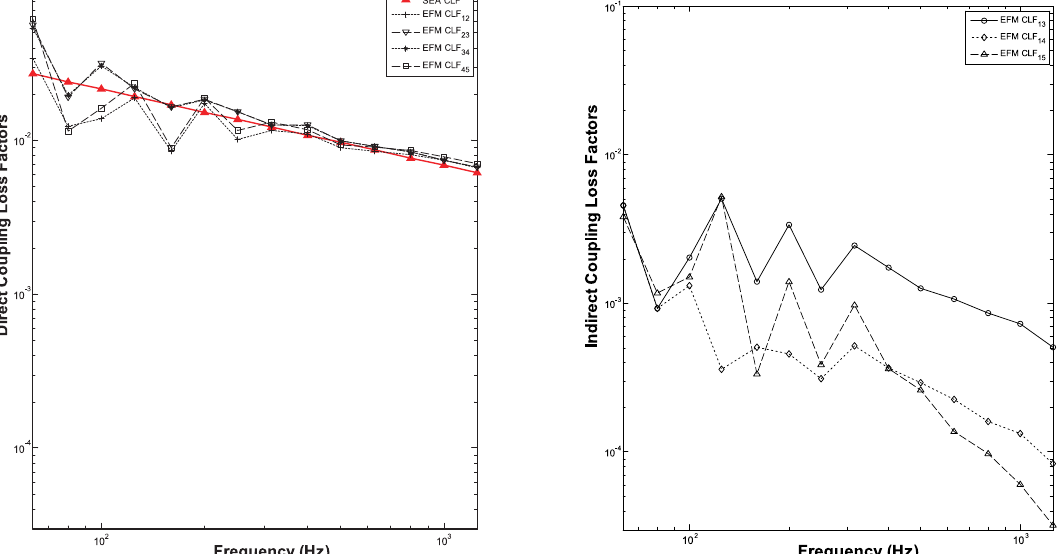
Fig. 9. Direct coupling loss factors by SEA and EFM. Fig. 10. Indirect coupling loss factors by EFM.